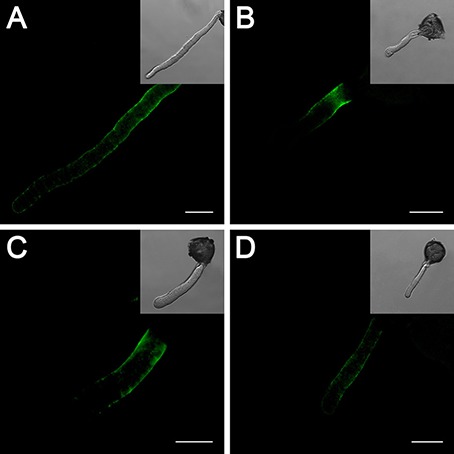
Effects of cold stress and DEA NONOate on the distribution of AGPs in C. sinensis pollen tubes. Pollen tubes incubated under standard conditions exhibited a characteristic dot-strengthening with remarkable periodicity of AGPs deposition along the entire length, as shown by immunolocalization with the LM2 antibodies, and the ring-like structures based on dot-strengthening were visualized in the apical region of the pollen tubes (A). After treatment with cold stress or 25 μM DEA NONOate, the AGPs distribution showed no dot-strengthened and ring-like structures, and the fluorescence signal was deposited only on the shank region of the pollen tubes (B,C). The fluorescence signal of the AGPs occurred along the entire pollen tube wall, including the tip region, under cold stress after 200 μM cPTIO treatment (D). Corresponding bright field images are shown at a reduced size. At least 20 pollen tubes were observed and photographed in each of three replicates, and one representative image per treatment was displayed. Bar = 20 μm.